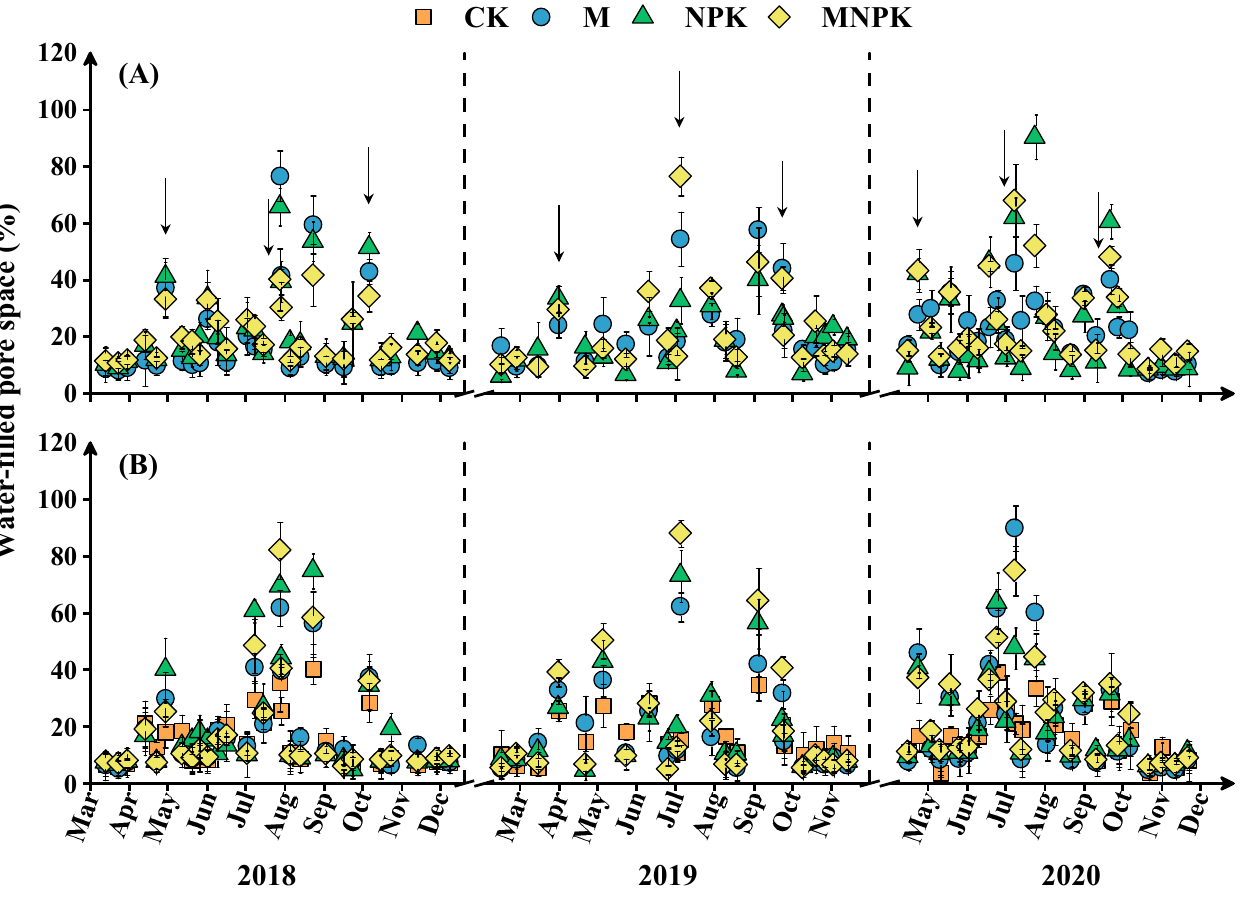
Figure 3. Seasonal dynamics of soil WFPS contents across the sampling sites and treatments from 2018 to 2020. ( A ) FD: fertilizer ditches WFPS, ( B ) BS: bare soil WFPS, CK: control, M: organic manure, NPK: chemical fertilizer, MNPK: chemical fertilizer combined with organic manure. The data points indicate the means of four replicates, and the error bars indicate the standard error (±SE). The black arrows represent the date of fertilizer application.